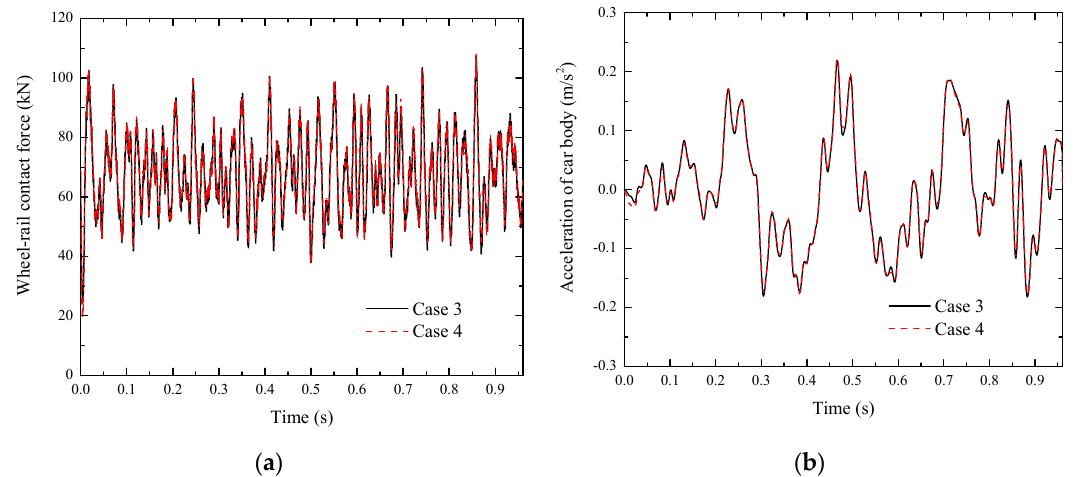
Figure14. Timehistorycurvesoftrain-trackinteractions: ( a )Wheel-railcontactforceand( b )acceleration of car